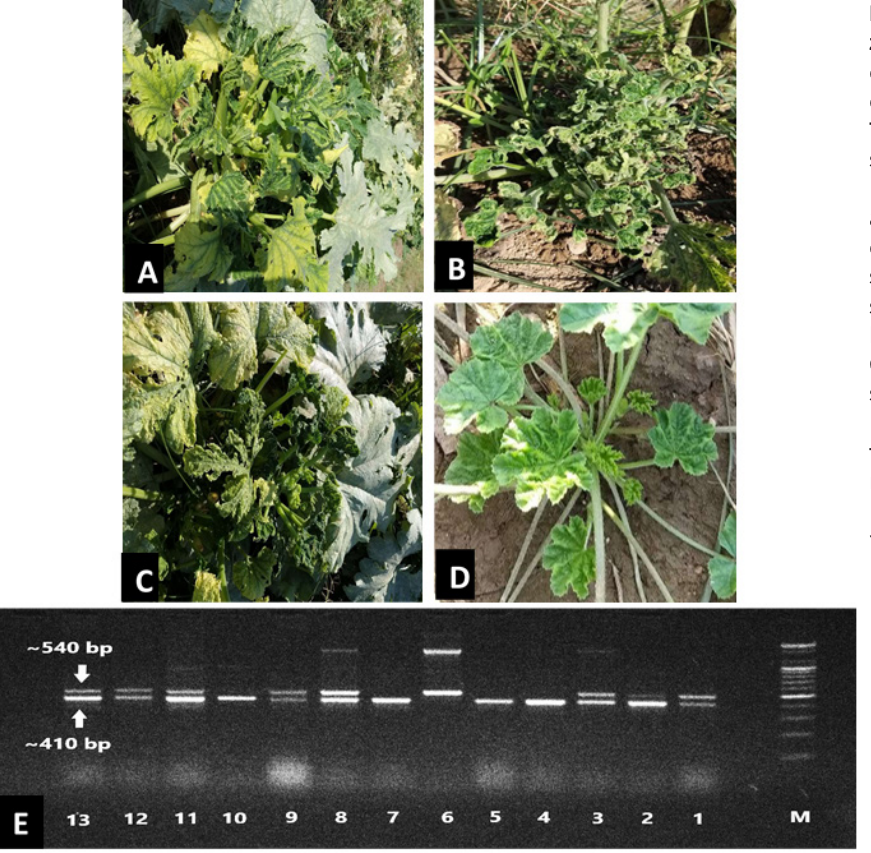
Figure 3. Naturally infected zucchini squash